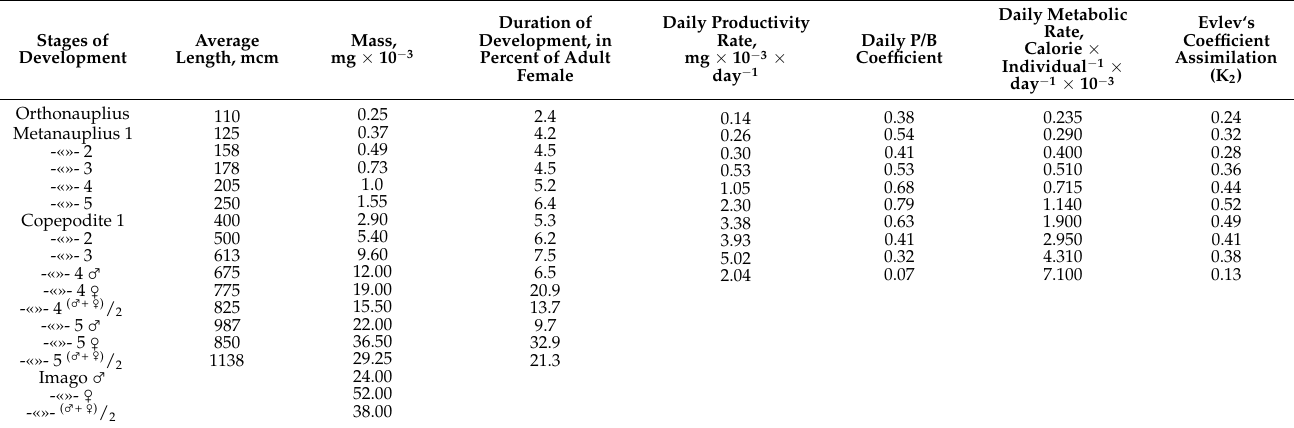
Table 1. Development, growth and productivity parameters of A. americanus (Marsh, 1893) in the Volga Delta river (Russia). Adult female duration of development at 20 ◦ C = 15.7 days ±